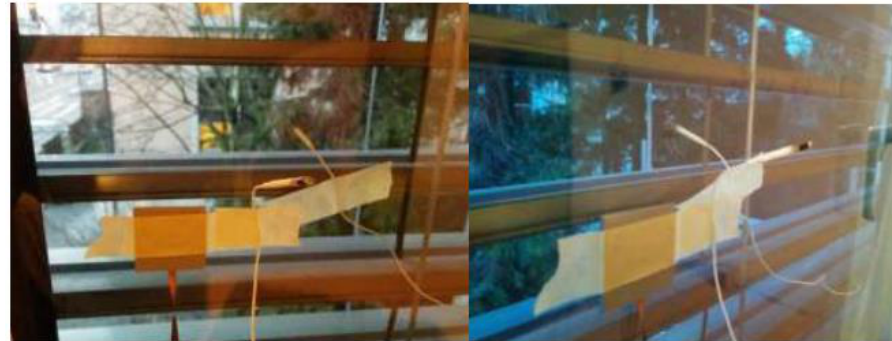
Figure 16. gSKIN Measurement Setup [31].